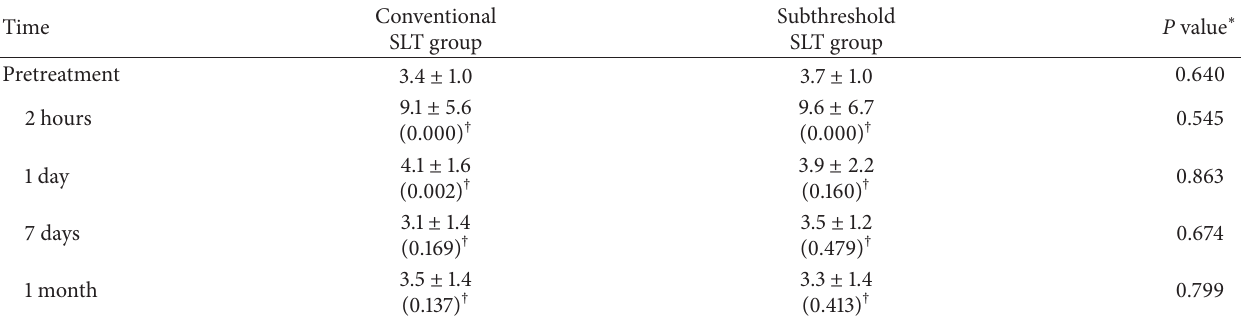
Table 4: Protein concentration of aqueous humor in conventional SLT group and subthreshold SLT group.